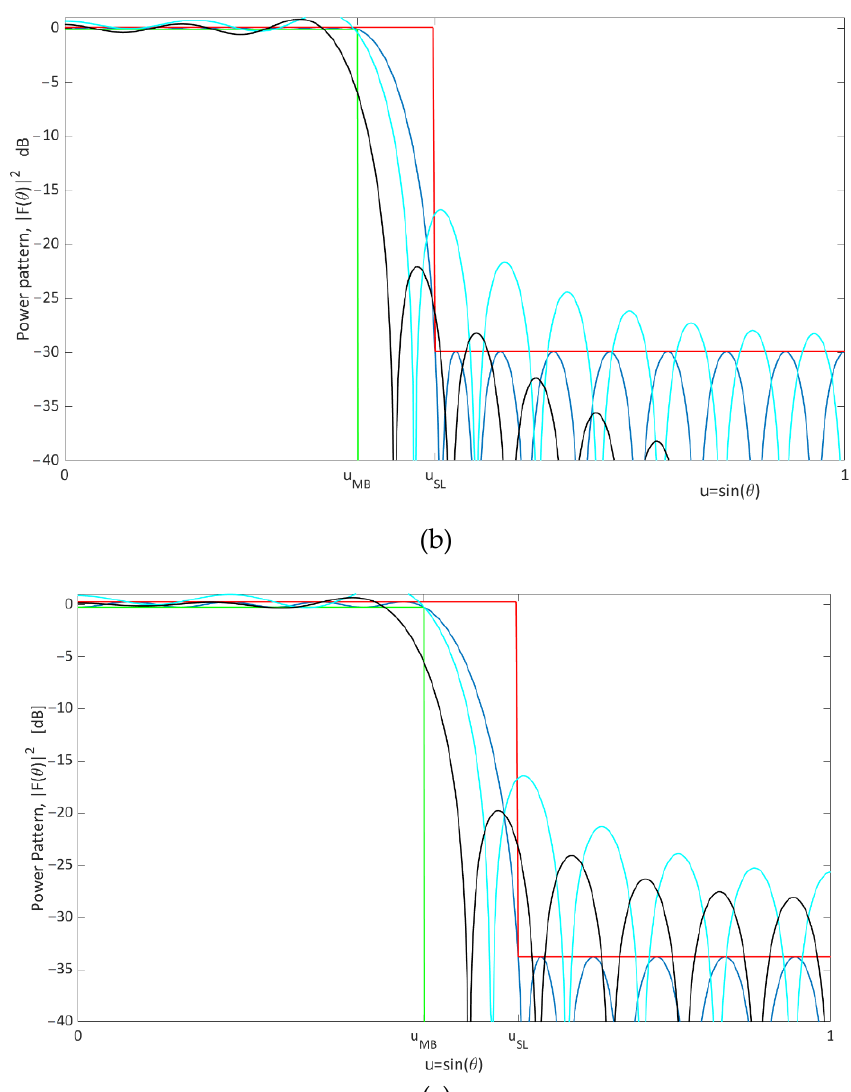
Figure 11. Comparison. The radiation patterns synthesized with the linear programming (blue lines), compared with the patterns of the Woodward – Lawson method (ciano lines) and those of the Fourier Transform approach (black lines) for the examples in ( a ) Section 4.1, ( b ) Section 4.2, and ( c ) Section 4.3. All of the patterns satisfy the imposed constraints.